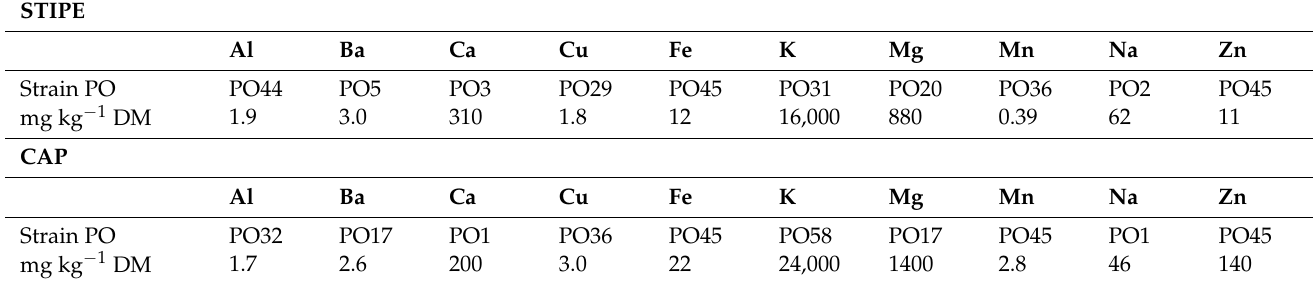
Table 4. Minimum concentrations of metals in the stipes and the caps of the monitored oyster mushroom